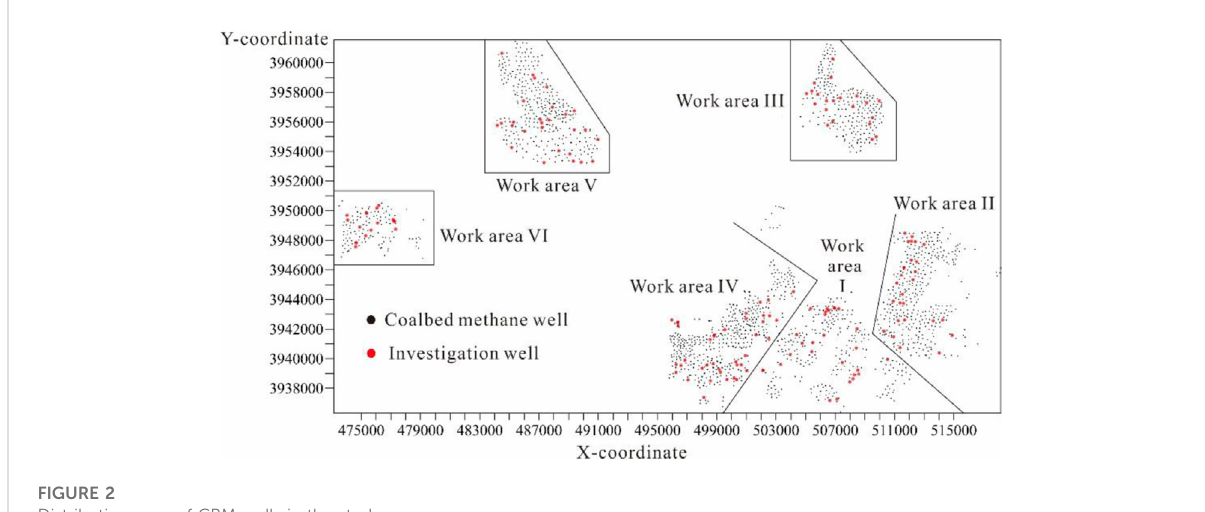
FIGURE 2 Distribution map of CBM wells in the study